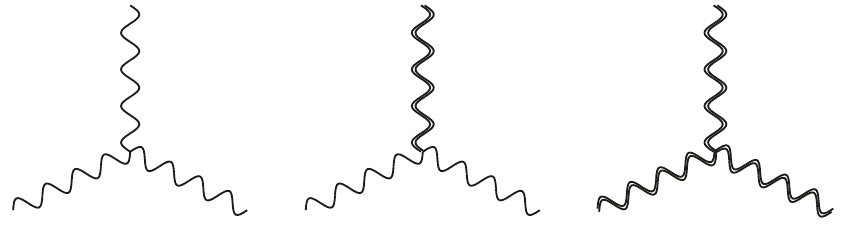
Figure 2 . Three vertices of EYM theory, the single wavy lines denote gluons while the double wavy lines denote gravitons. In the second diagram, the single wavy lines can also be understood as